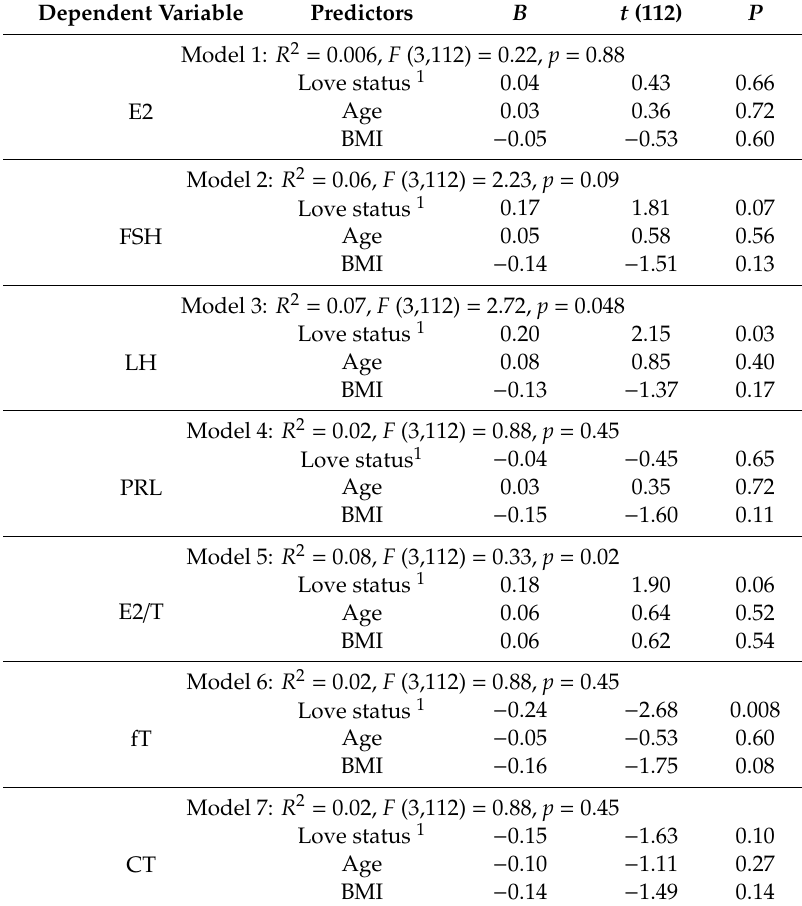
Table 2. Results of regression analyses examining the relationships between romantic relationship status (single vs in love) and hormone levels, controlling for age and BMI ( N =